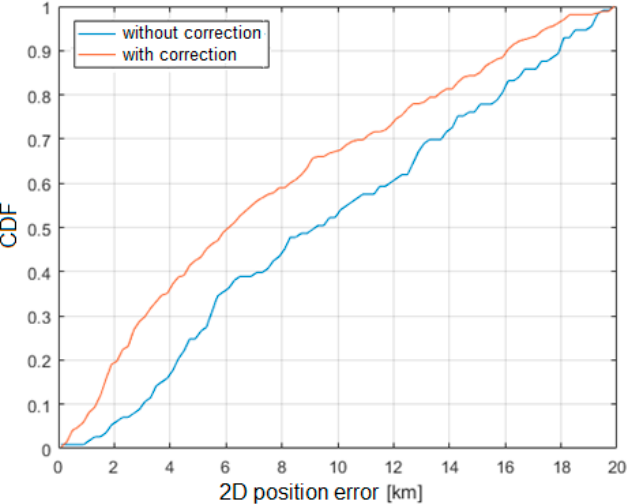
Figure 21. Cumulative distribution function of horizontal position estimation error (SI algorithm).